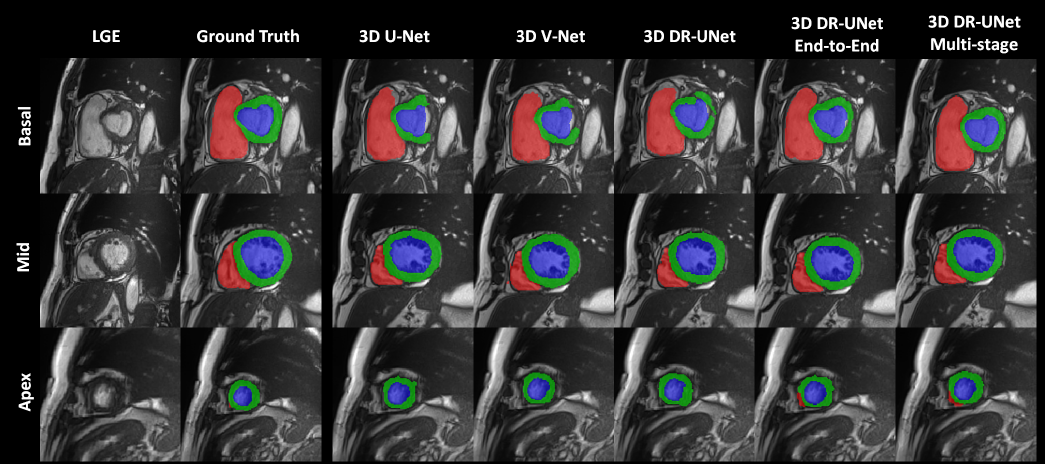
Figure 5. Figure depicts segmentation of the RV, LV, and MYO at the ED phase, for a test sample from the ACDC dataset, generated using each network. Rows from top to bottom depict the basal, middle and apical slices, respectively. In all figures, red, blue and green represent the RV, LV, and MYO,